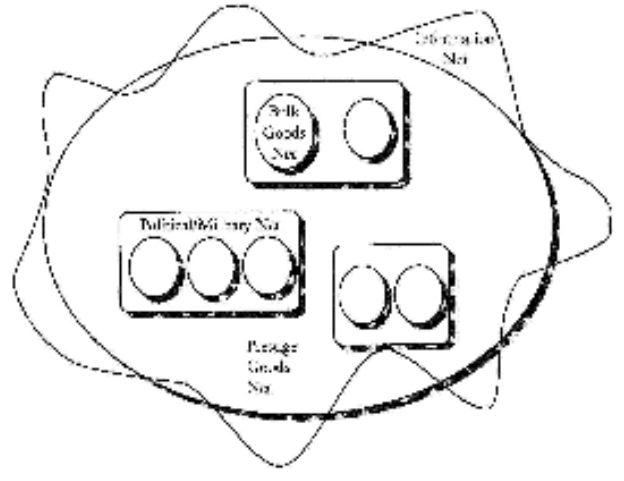
(from Chase-Dunn and Hall